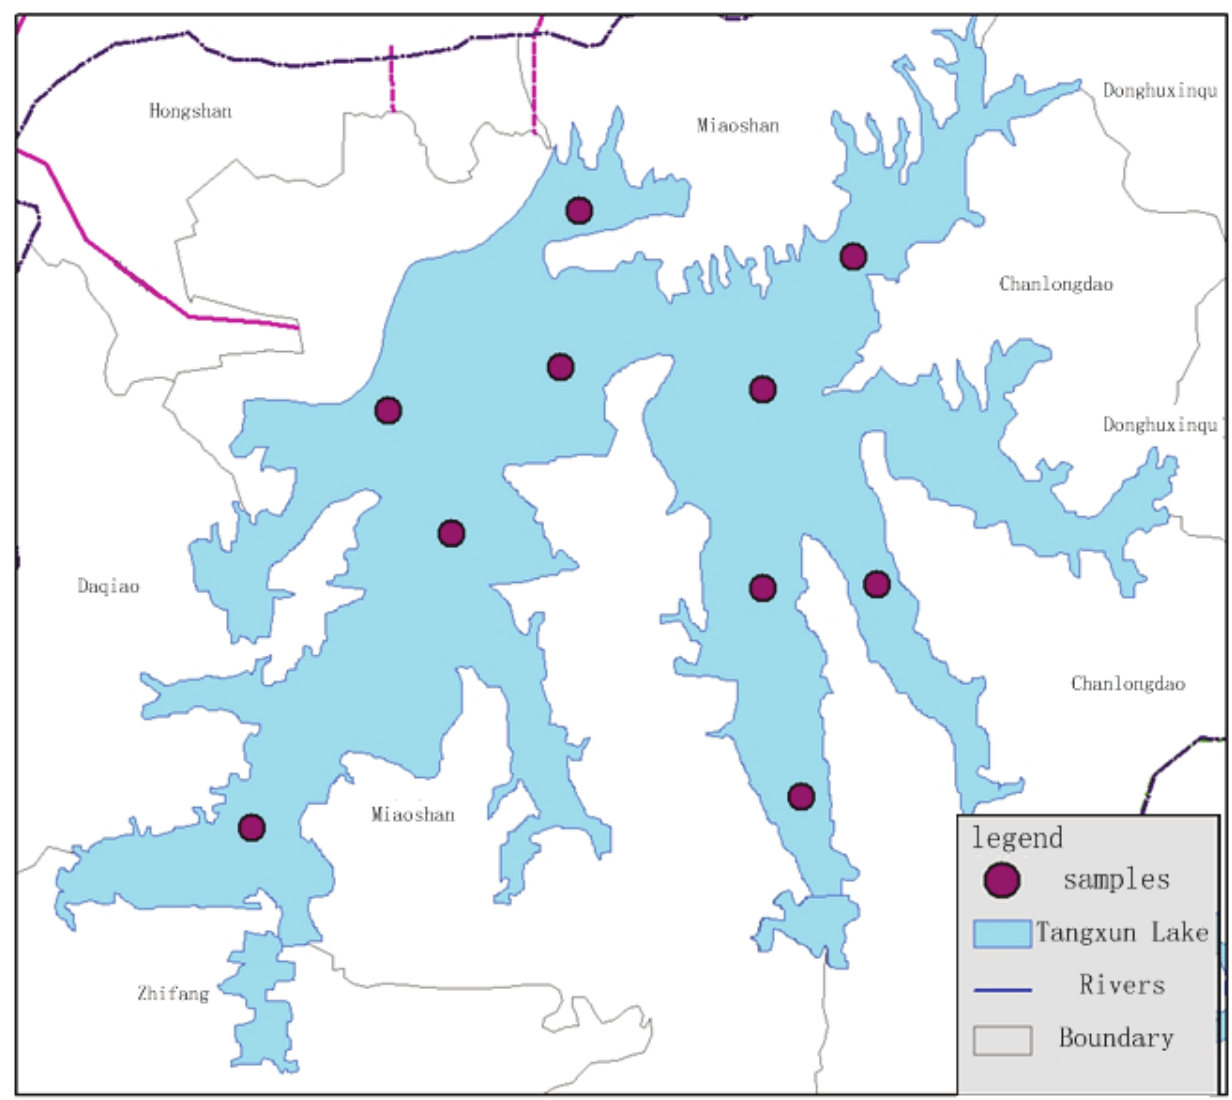
Figure 1. Study area and sampling